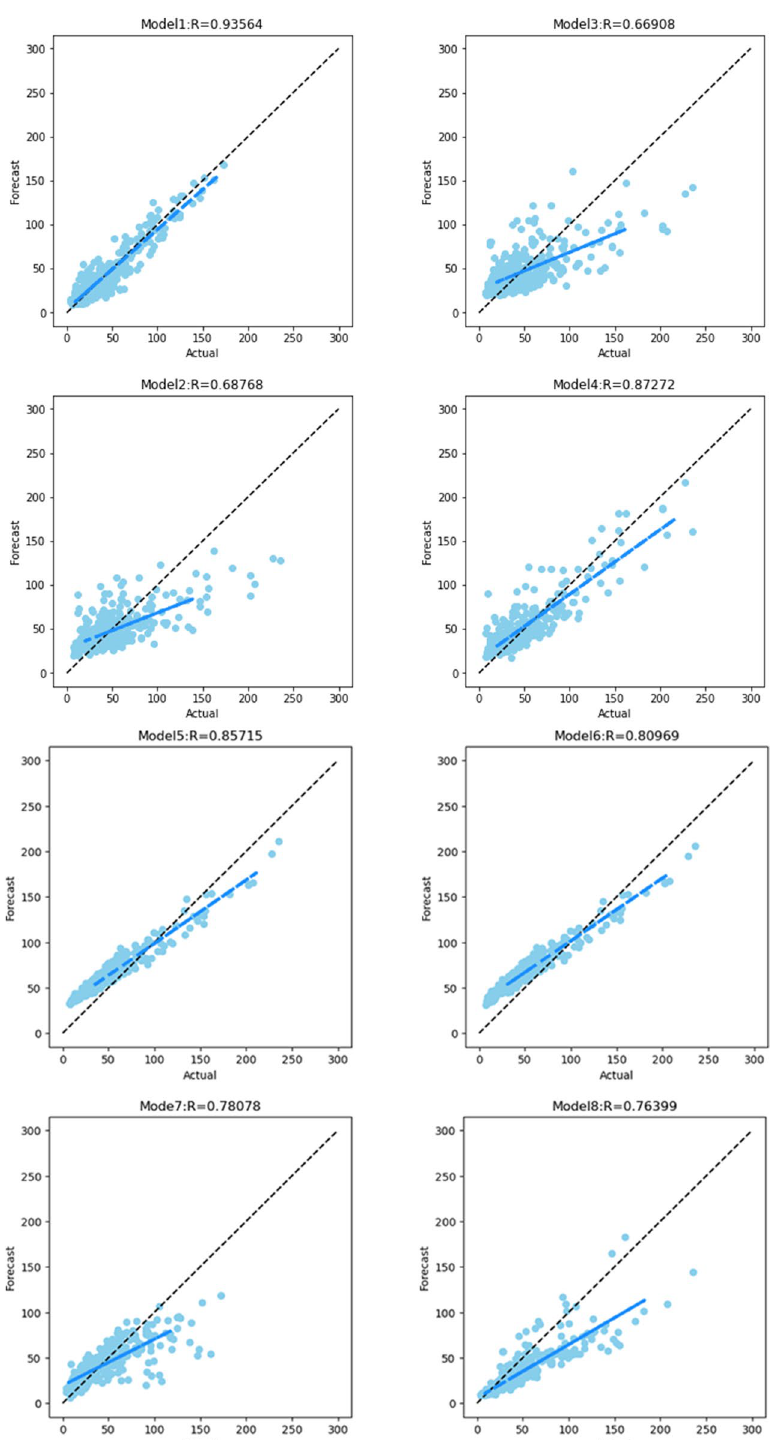
Figure 7. Scatterplots of the actual and forecast PM2.5 values achieved using various models (Binzhou data). Model 1: CEEMDAN-PSO-CNNLSTM. Model 2: PSO-LSTM. Model 3: PSO-CNN-LSTM. Model 4: CEEMAND-PSO-LSTM. Model 5: CEEMDAN-SVM. Model 6: SVM. Model 7: BP. Model 8: